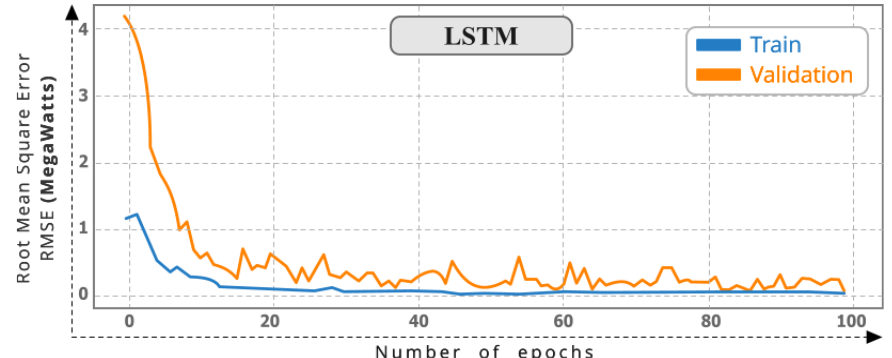
Figure 4. LSTM loss function behavior according to the number of epochs.